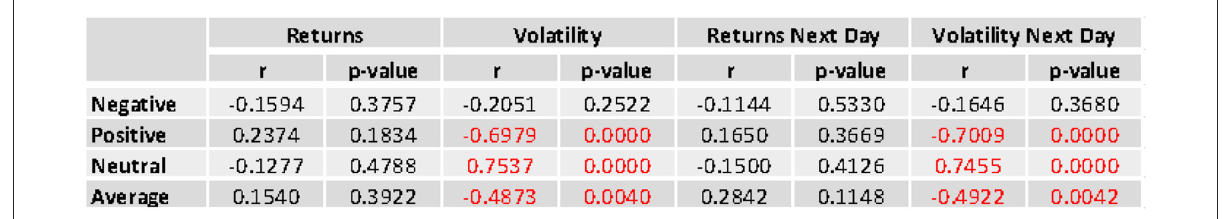
FIGURE4 Tweets dataset: Correlation coefficients and p -values for lagged and non-lagged returns; statistically-relevant results are in red.